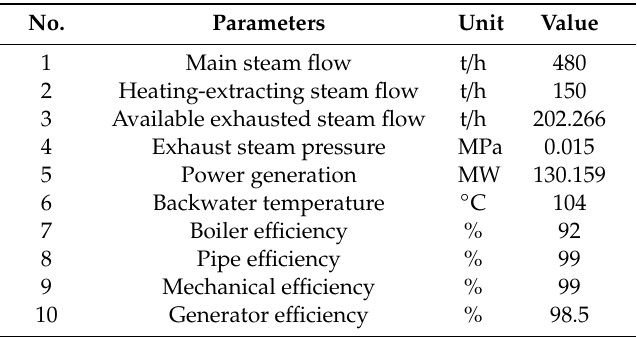
Table 1. Detailed thermal parameters of the case unit.